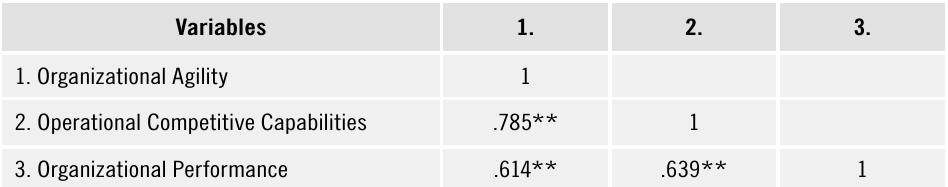
Table 4. Correlation analysis results